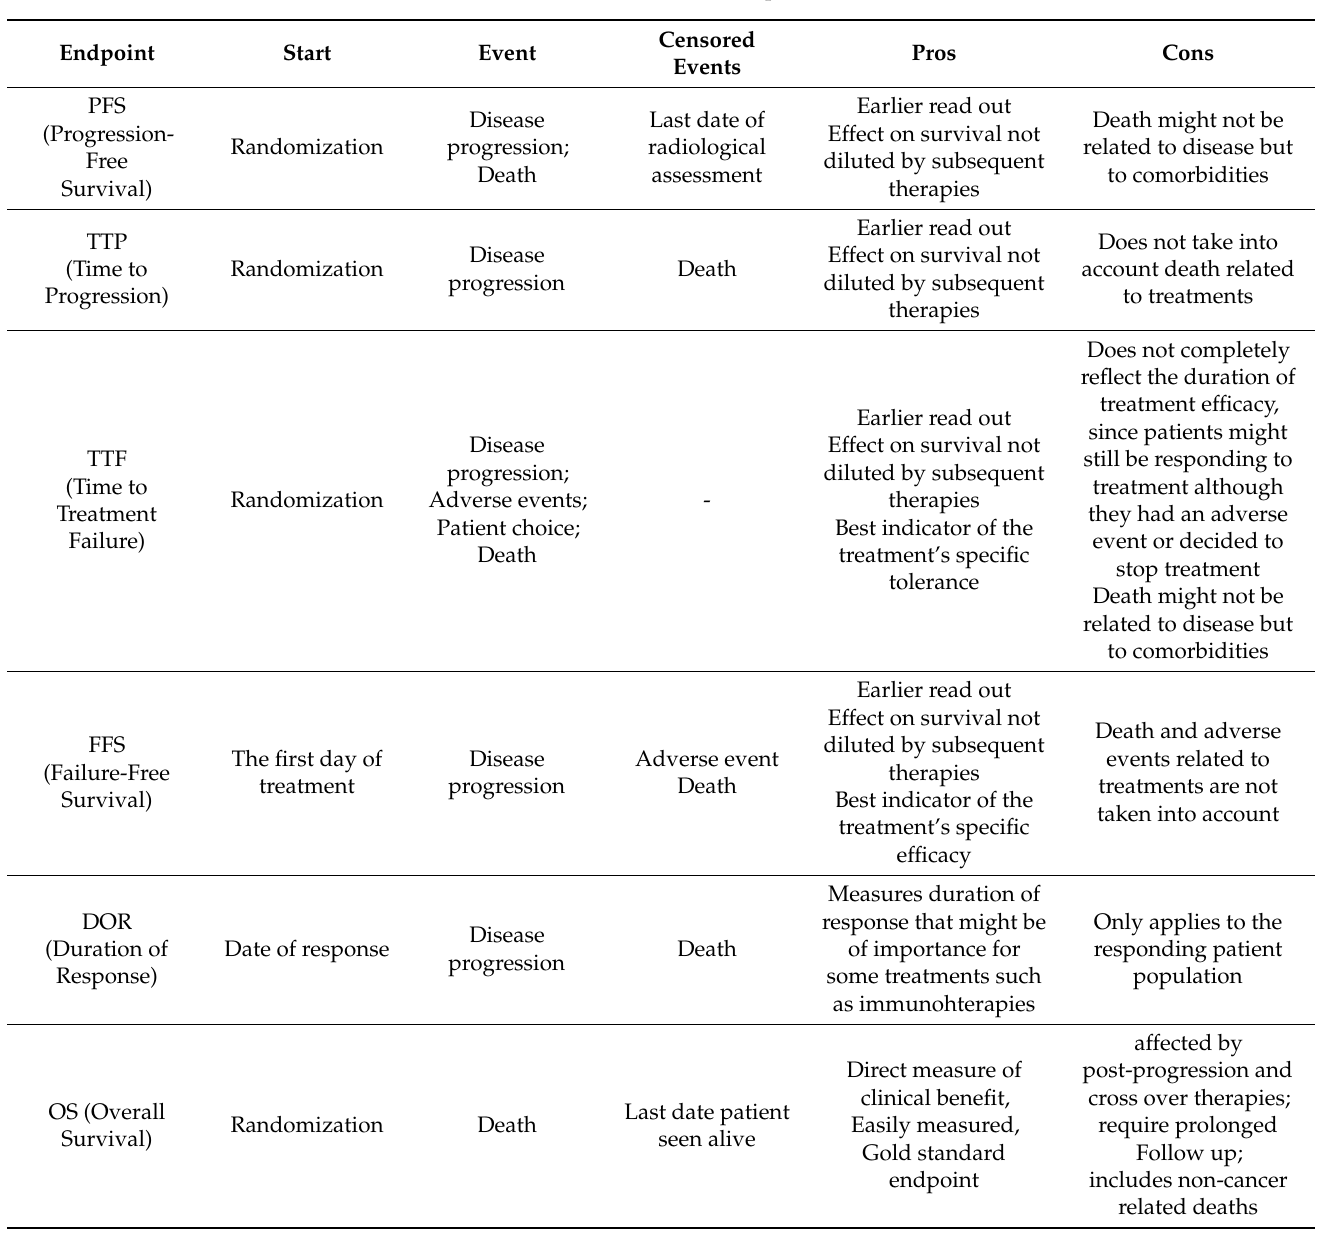
Table 1. Survival-based